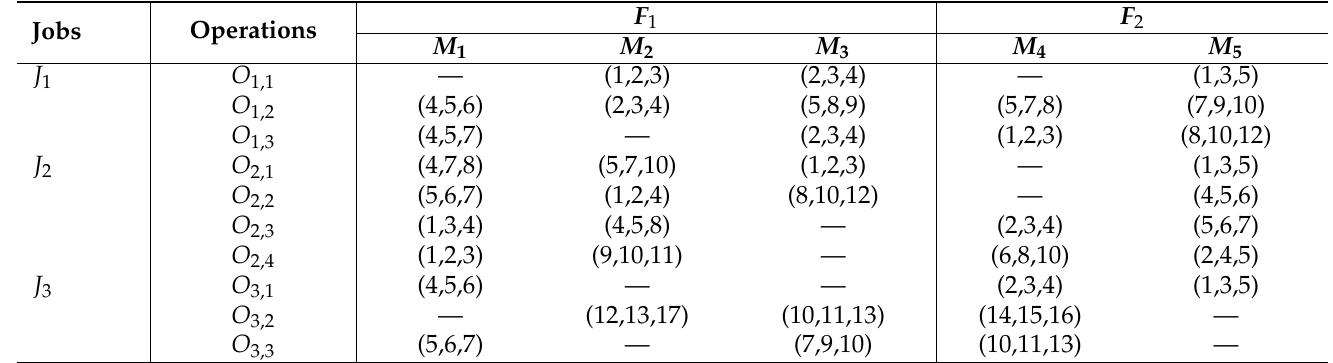
Figure 2. Solution representation. Table 1. Example of